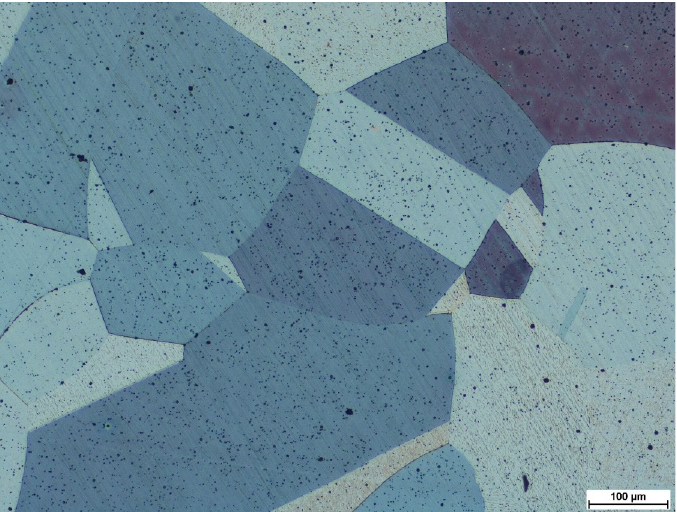
Figure 1. Material microstructure of the X120Mn12 steel in the as-delivered state. Microstructure of coarse-grained austenite with twins. Etched state. LM.